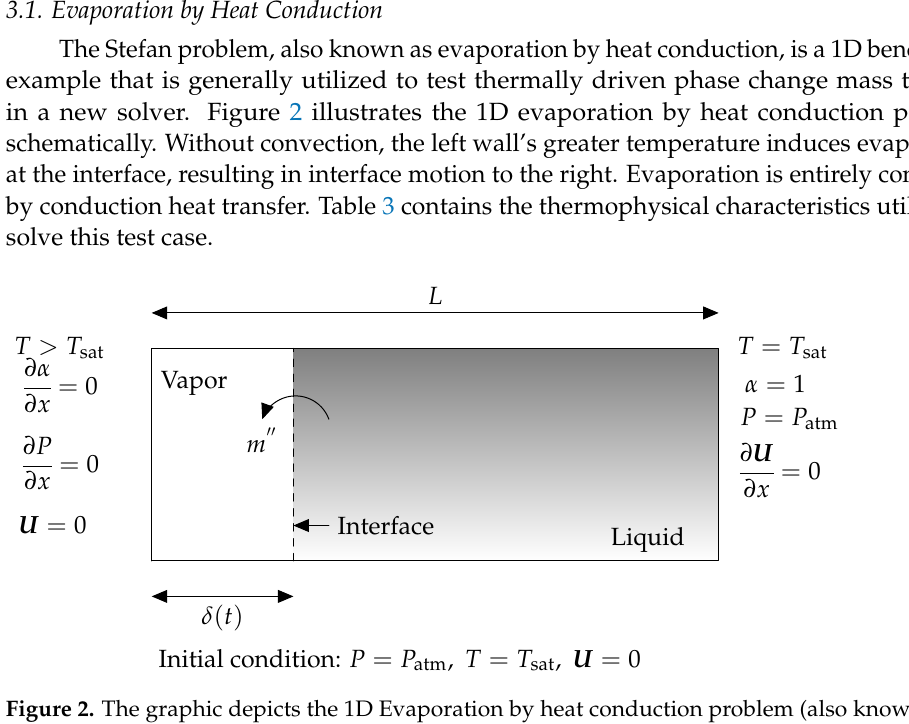
Figure 2. The graphic depicts the 1D Evaporation by heat conduction problem (also known as the Stefan problem) and the boundary conditions associated with it. Gray denotes liquid, while white denotes a part of geometry that is filled with vapor at a saturated temperature. The phase change occurs at the gas–liquid interface, shown by the dashed line. Phase change is induced when the wall in contact with the vapor reaches a temperature greater than superheat. As a result of the evaporation phase change previously described, the interface, which also serves as a measure for the vapor layer thickness, is shifting to the right. Table 3. Base fluid, nanoparticles, and gas properties used in the evaporation by heat conduction (also known as Stefan problem) and condensation by heat conduction (also known as Horizontal film condensation problem) benchmark cases. These two benchmark cases are presented and solved in Sections 3.1 and